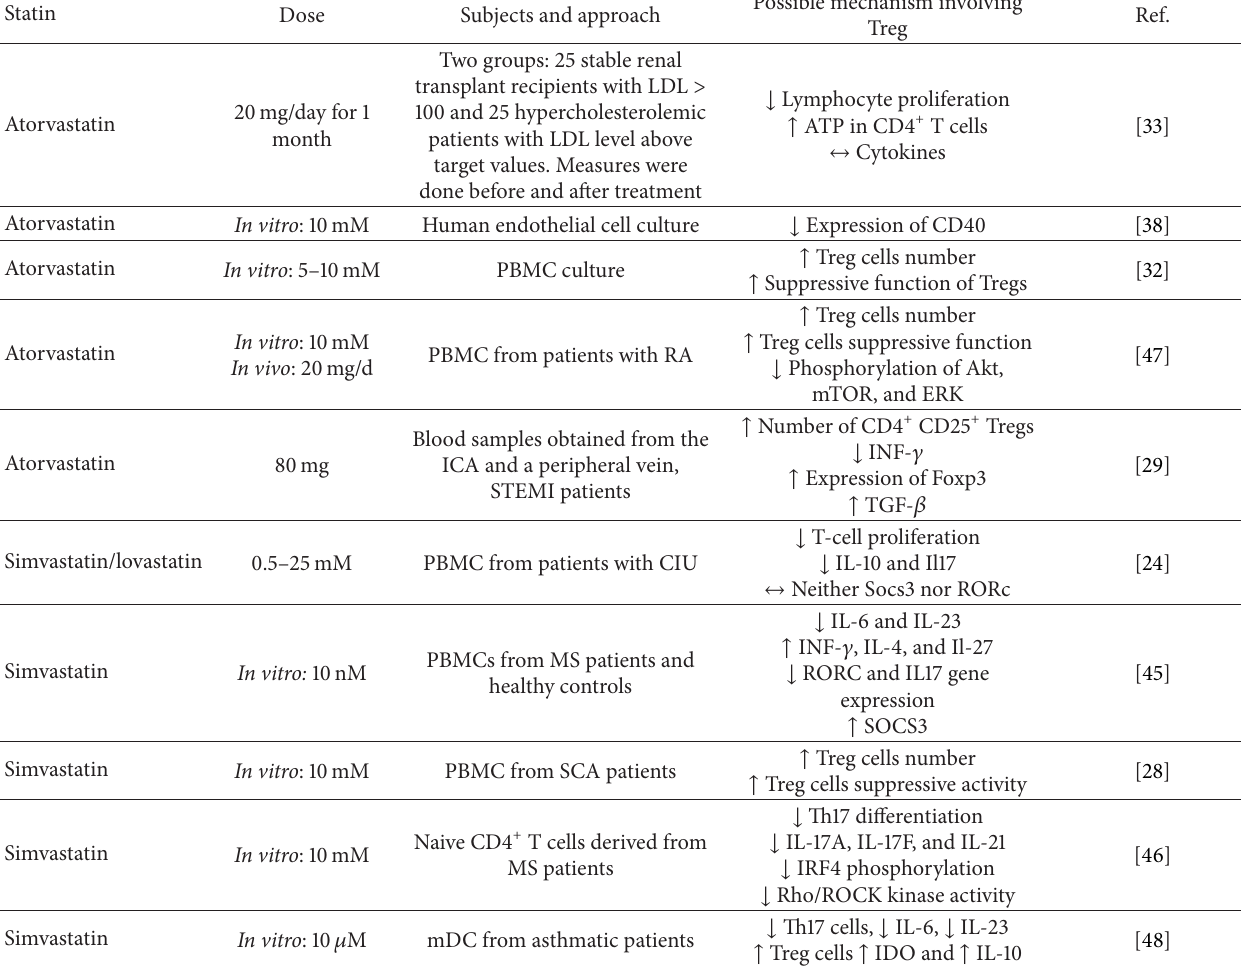
Table 2: Evidences on the modulation of Treg cells by statins in